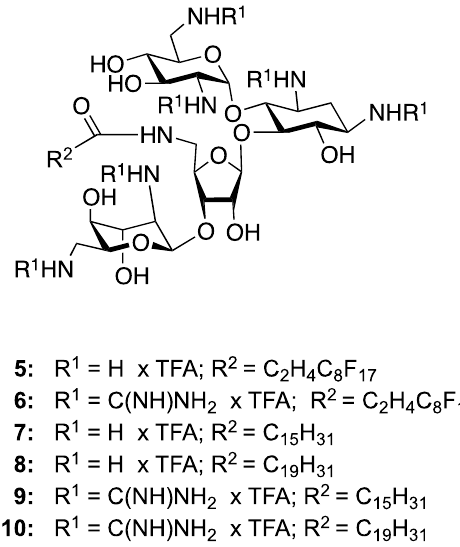
Figure 1. Structures of neomycin B-based bilipids 1 – 4 , the fluorinated monolipids 5 and 6 , and the previously reported hydrocarbon monolipid-neomycin-B amphiphiles 7 – 10